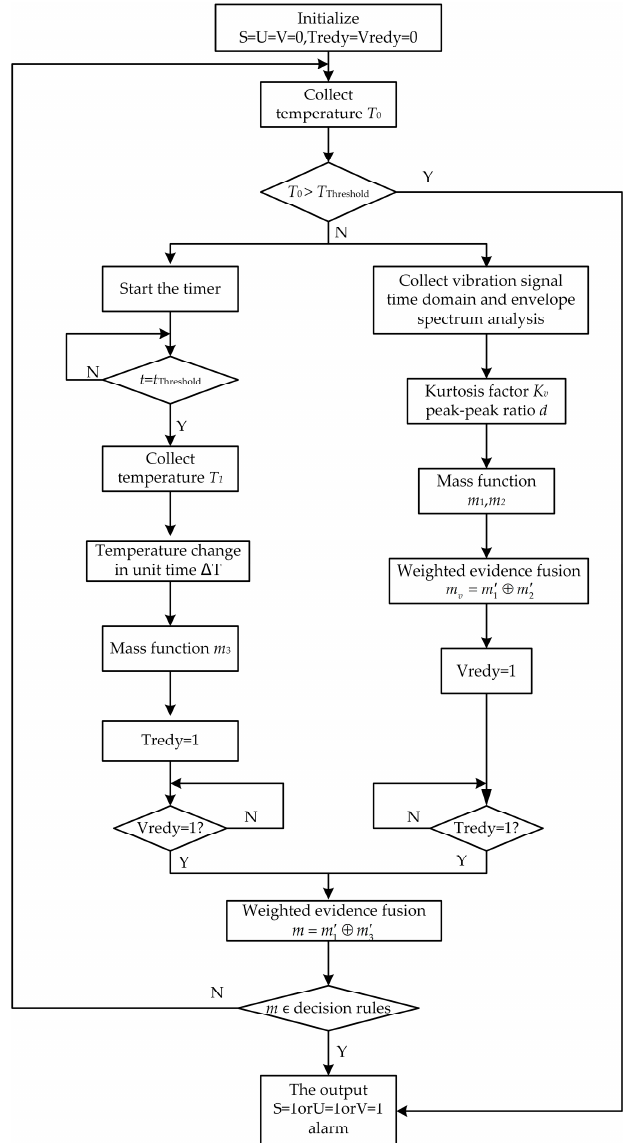
Figure 2. The flow table of bearing fault diagnosis.